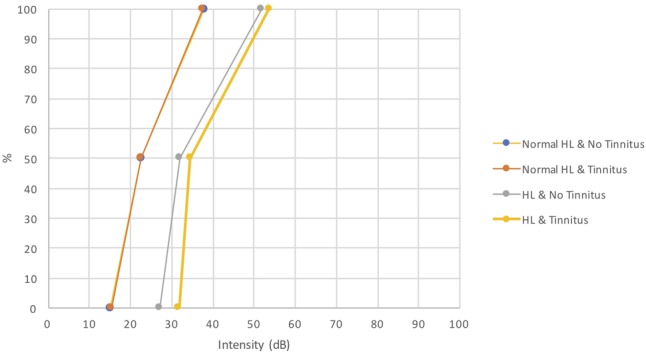
Speech audiograms between subgroups.